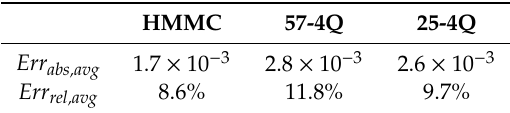
Table 6. Error of modeling results of molar fraction at the sampling point, versus experimental data. The errors are averaged over the experimental data available, for each catalyst investigated in this